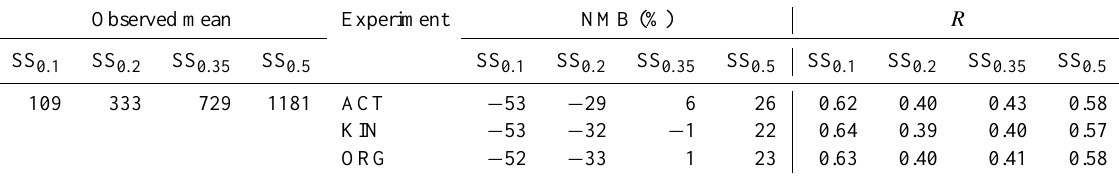
Table 6. Same as Table 5, except for the T1